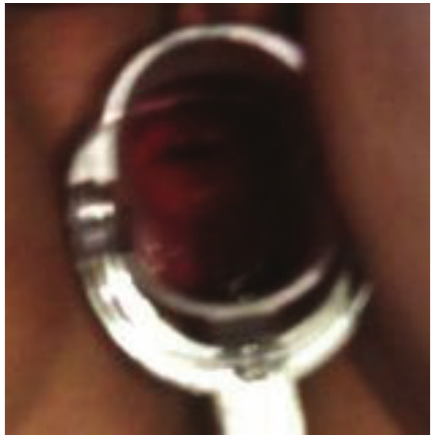
Figure 1: Cervical position at 12 months postpartum.